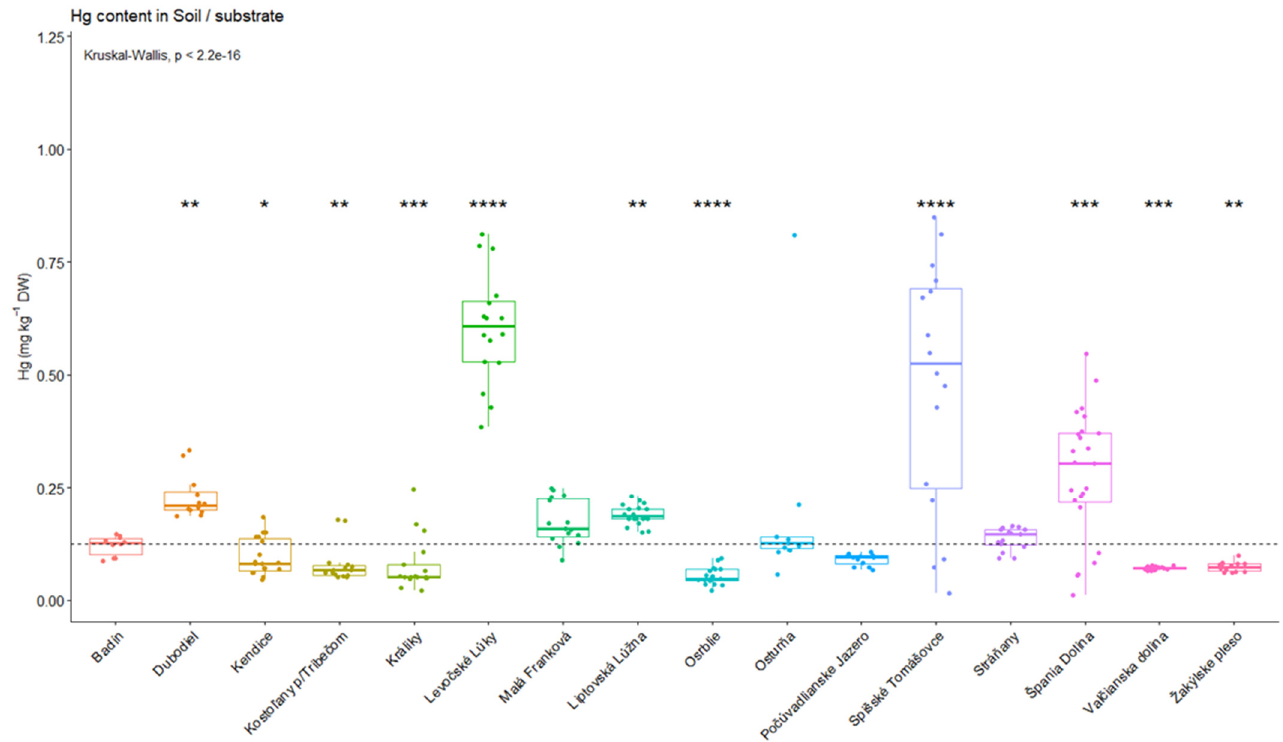
Figure 2. Significant differences in soils/substrate mercury concentrations in mg kg − 1 , concerning localities (* p < 0.05; ** p < 0.01; *** p < 0.001; **** p < 0.0001).